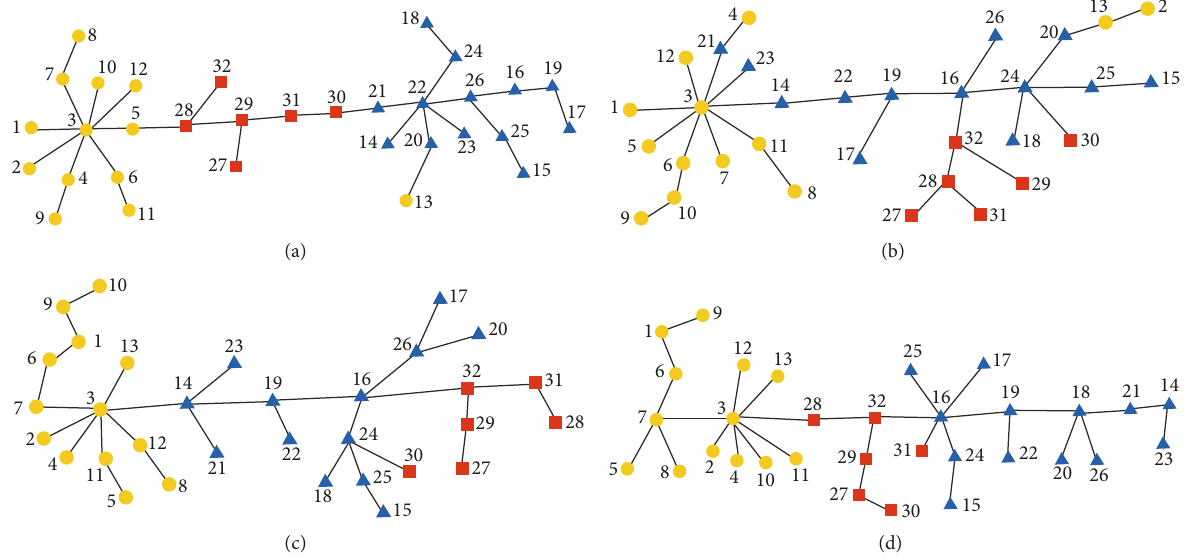
Figure 8: The MaxSTs for the contagion distribution in different windows. (a) The MaxST for the 5th window. (b) The MaxST for the 15th window. (c) The MaxST for the 25th window. (d) The MaxST for the 35th window. Asian and Oceanian markets are shown as yellow circles. European markets are shown as blue triangles. American markets are shown as red